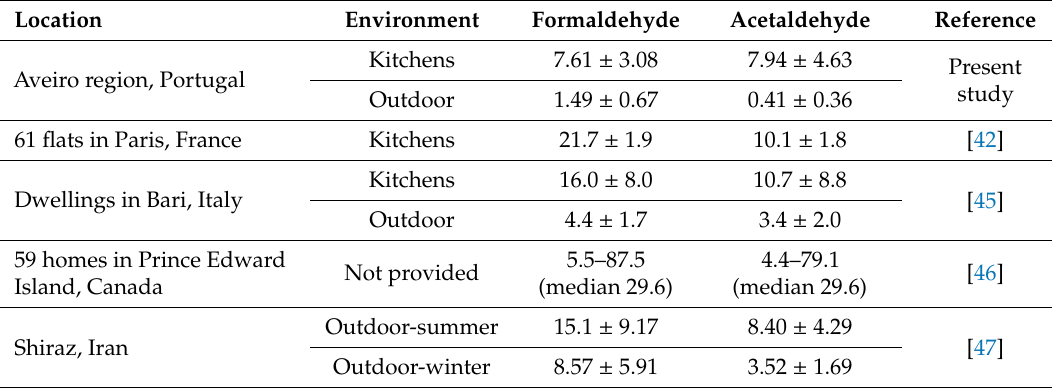
Table 3. Comparison of carbonyl concentrations ( µ g m − 3 ) obtained in the present study with those reported for other